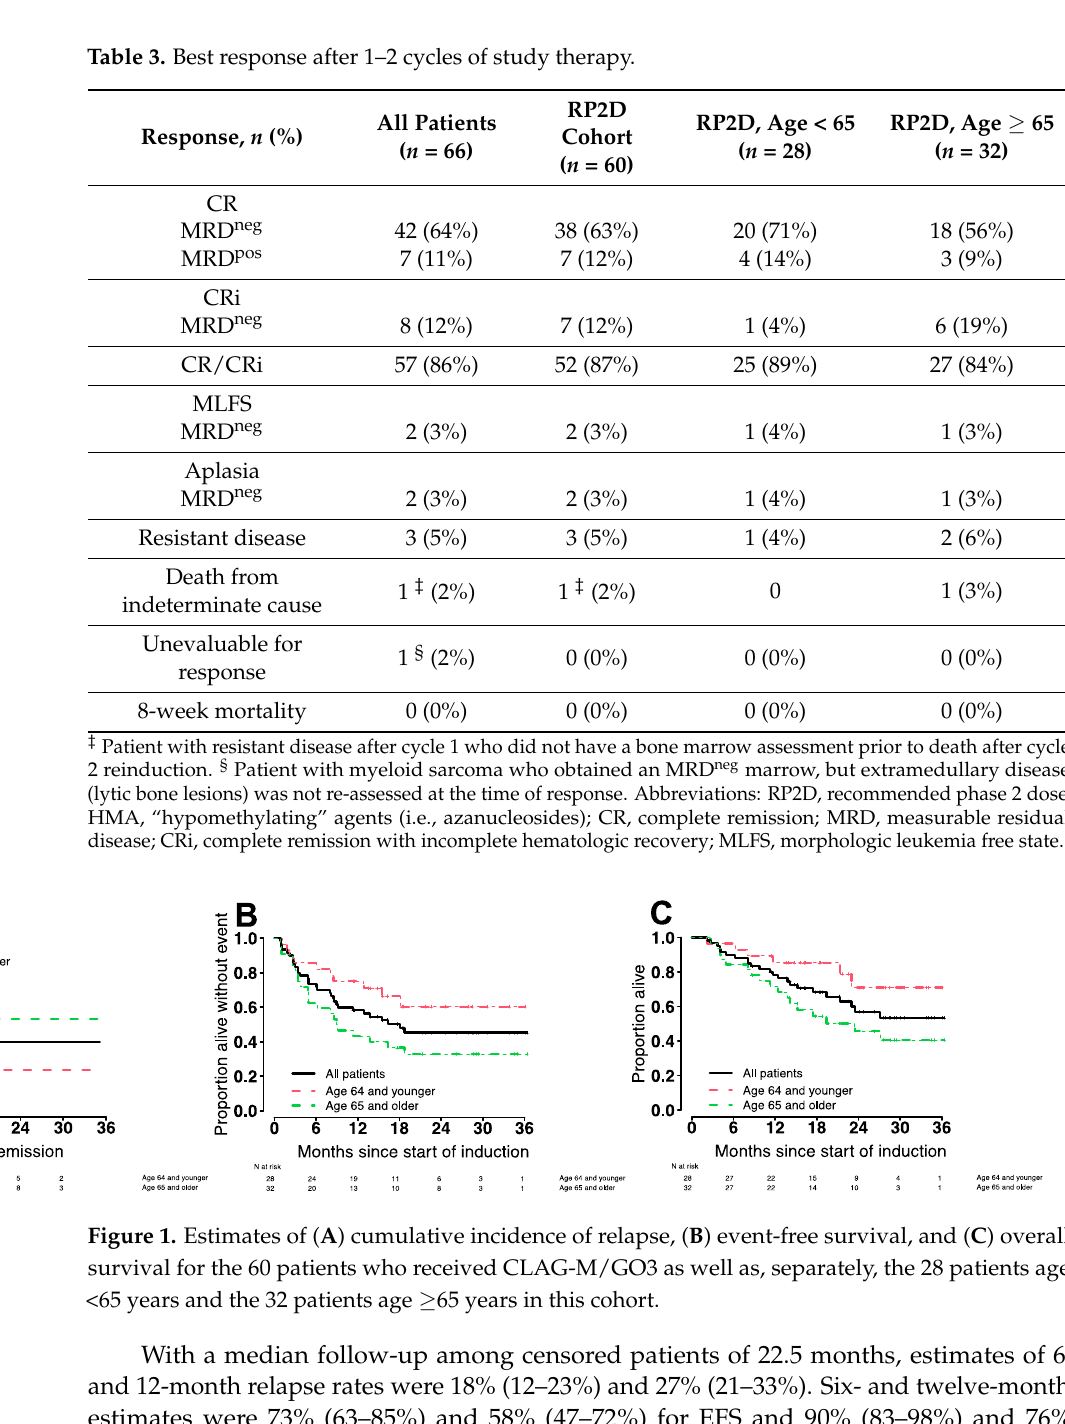
Table 4. Outcome probabilities (with 95% confidence interval) in entire RP2D cohort and stratified by age or cytogenetic/molecular disease risk.